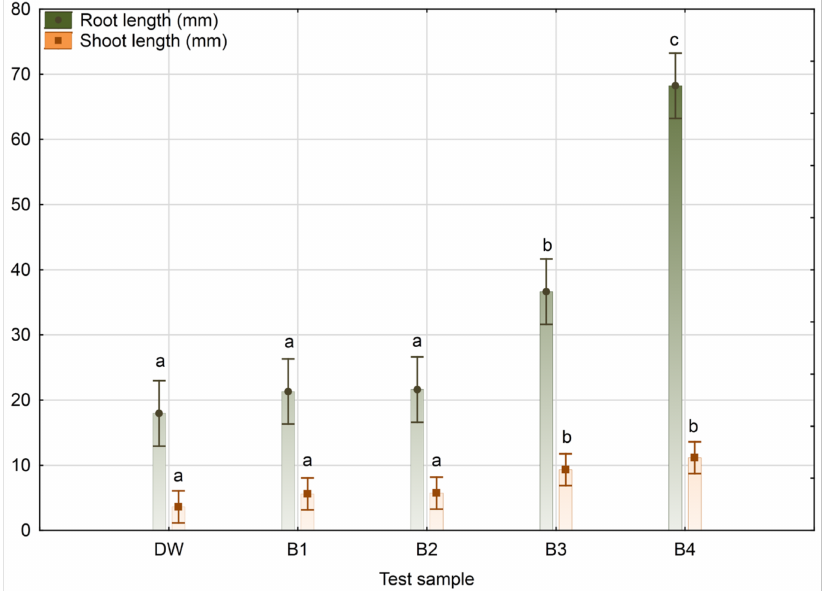
Figure 6. Mean values and standard deviations of maize root and shoot length for seeds treated with distilled water (DW) or Bacillus sp. BioSol021 cultivation broth samples produced under different cultivation conditions: B1: 0.5 vvm, 100 rpm; B2: 0.5 vvm, 300 rpm; B3: 1.5 vvm, 100 rpm; B4: 1.5 vvm, 300 rpm. Superscript letters designate different levels of statistical significance (with p -values over 0.05) according to Duncan’s multiple range